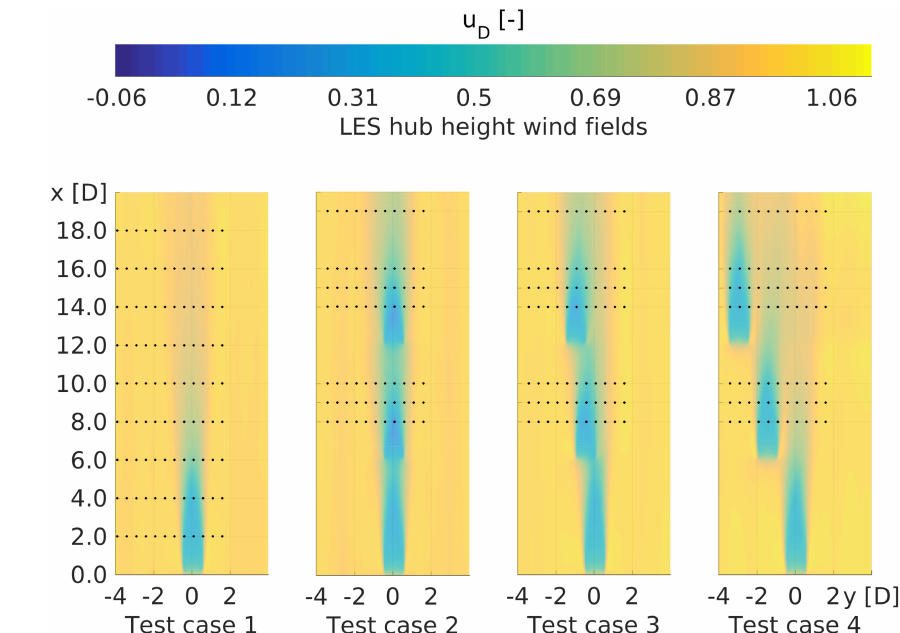
Figure 3. Colour map of the hub height wake velocity u D evaluated for the test cases from the large-eddy simulations (LESs). The black dots indicate the position of the virtual turbine rotors used to compare the simulation